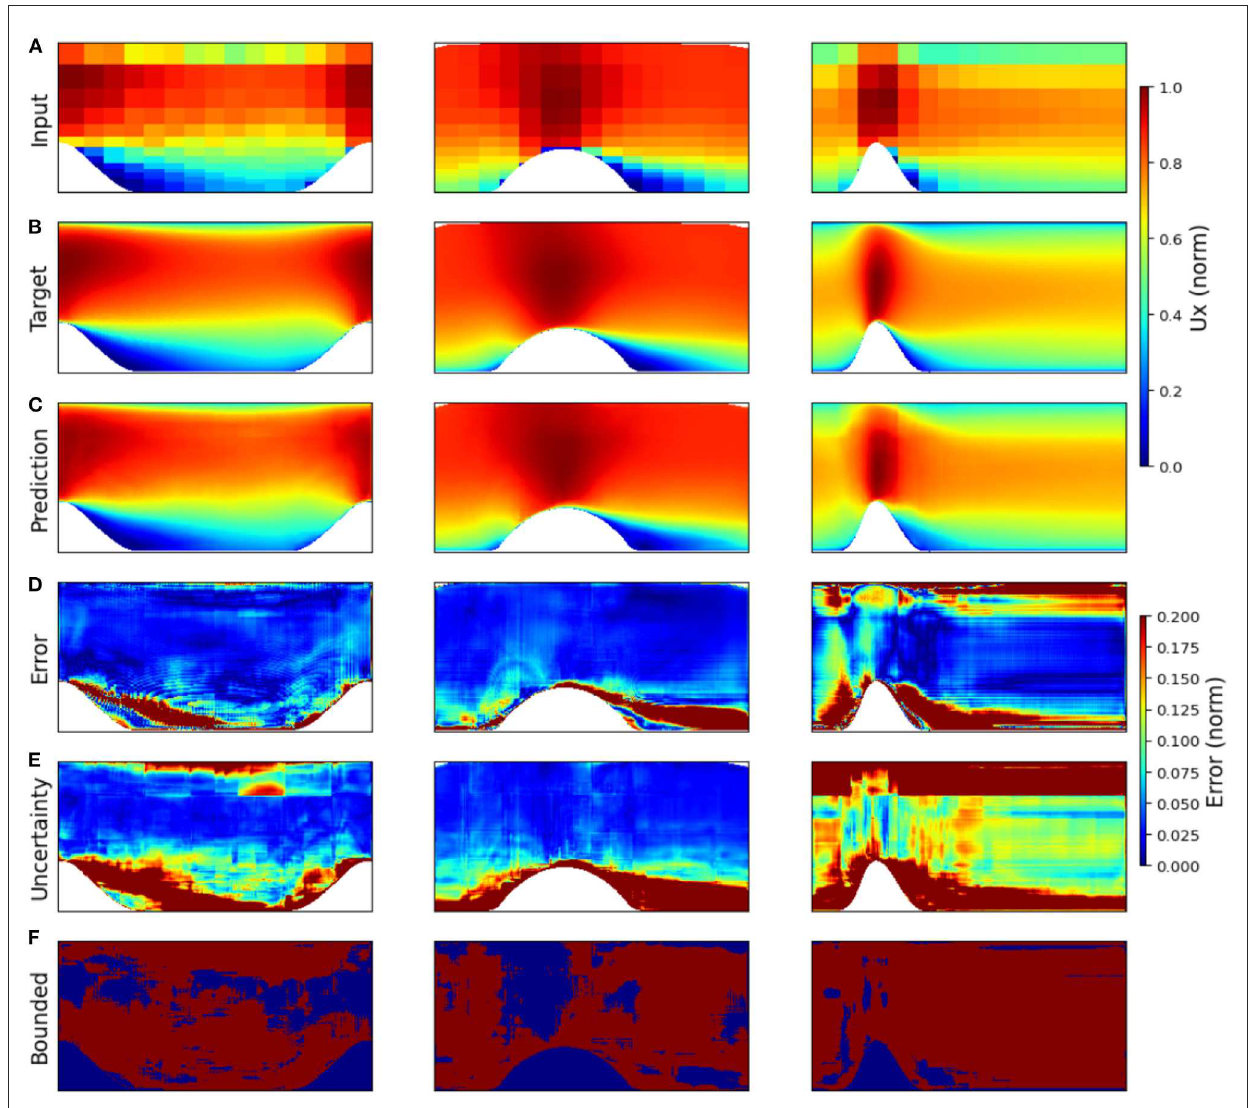
FIGURE4 Results for the different test cases of the mean flow example taken from McConkey et al. (2021). The dimensionality and aspect ratio of each case varied significantly, and are shown as dimensionless reconstructions on a 512 756 grid for ease of visualization. The x component of velocity, U x , is × shown, with the tessellated input (A) , the target values (B) , and the predicted values (C) all normalized between 0 and 1. The relative error (D) and relative uncertainty (E) are shown for each case. Finally, the areas where the epistemic uncertainty bound the observed error are shown in a binary color-coded format (F) where red indicates a pixel is bounded, and blue indicates it is